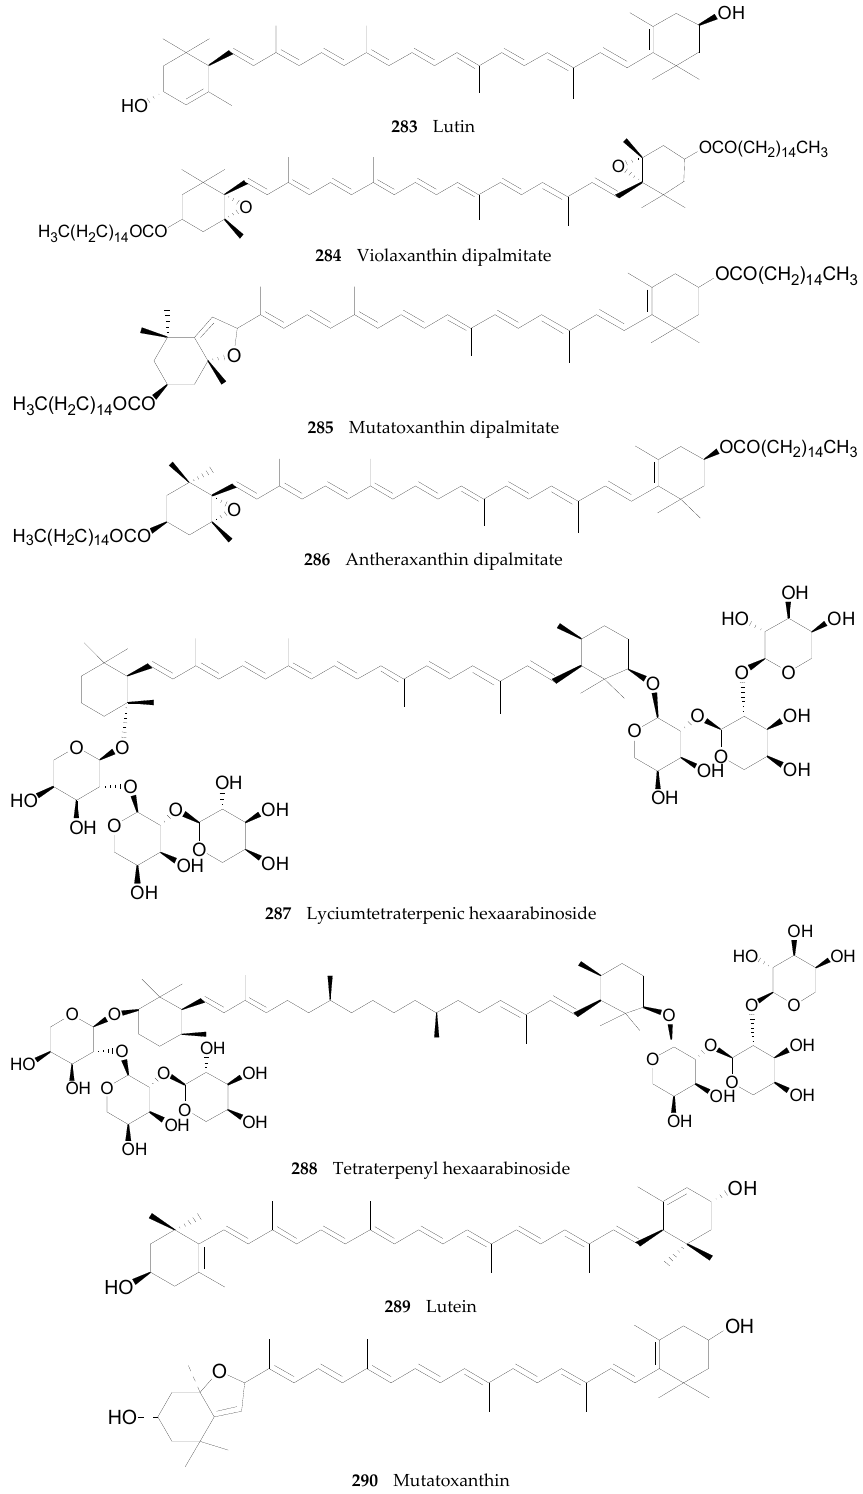
Figure 21. Chemical structures of compounds 283 – 290 .